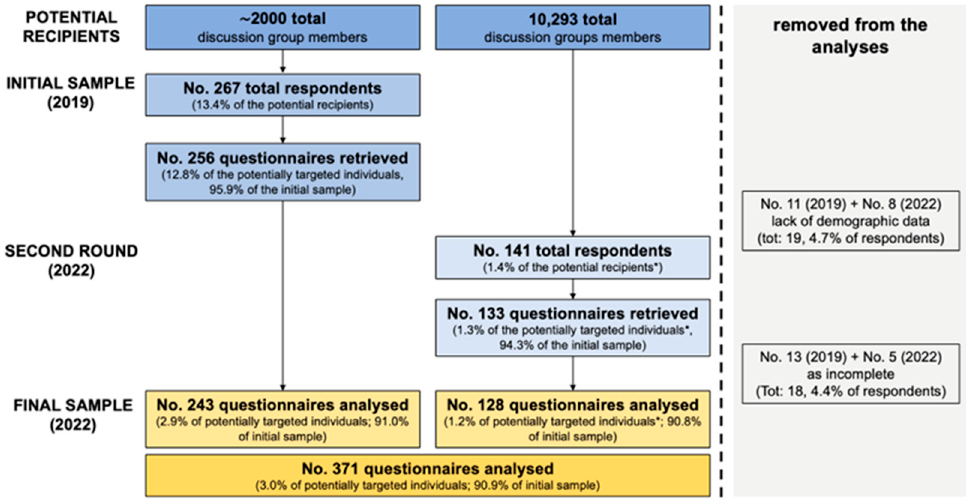
Figure 1. Flow chart of the study participants, Italy 2019 and 2022. Note: * = total number of Occupational Physicians included in the parent groups not available; the share of potentially targeted individuals is therefore calculated on the total number of group members.